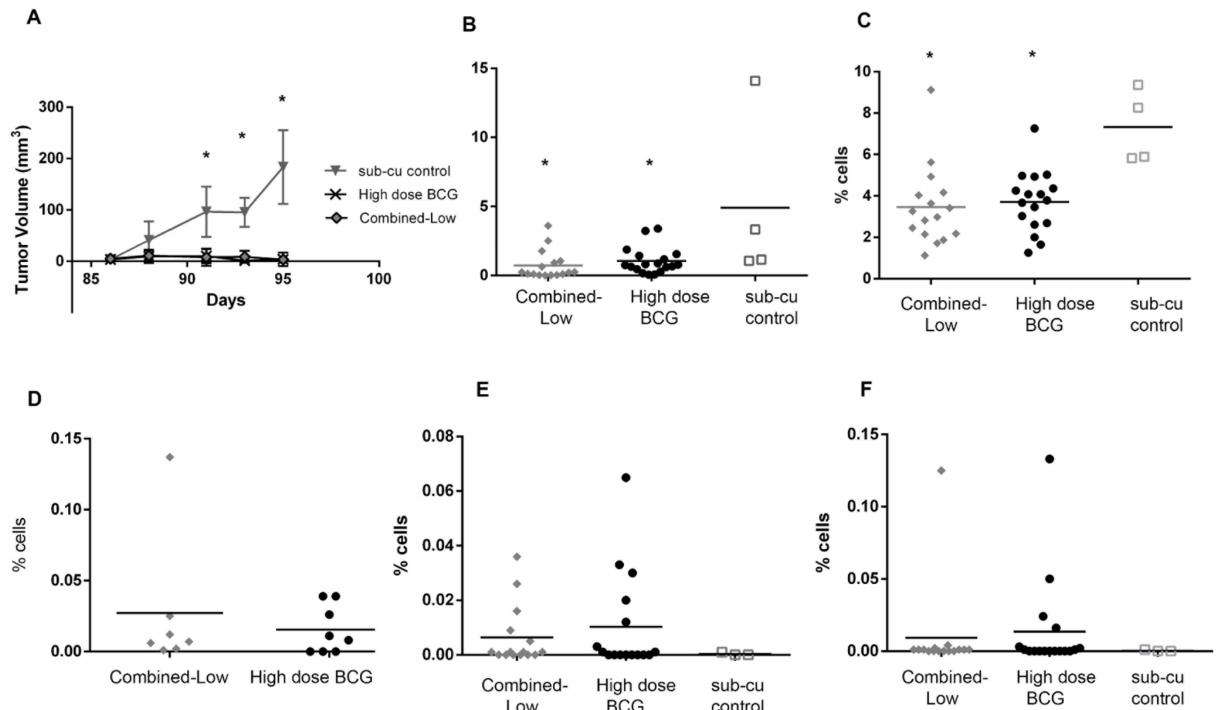
Figure 5. Response to re-challenge with MB49PSA tumor cells. ( A ) Response to subcutaneous tumors in cured and aged matched naïve mice was monitored for 10 days and expressed as tumor volume with time (* p < 0.05 one-way ANOVA (Bonferroni, against sub-cu control). Splenocytes were isolated from mice in all three groups and analyzed by flow cytometry for ( B ) CD4 + ICOS + T cells and ( C ) NK cells (* p < 0.05 one-way ANOVA (Bonferroni, against sub-cu control).). Antigen specific T cells recognizing ( D ) BCG, ( E ) PSA and ( F )